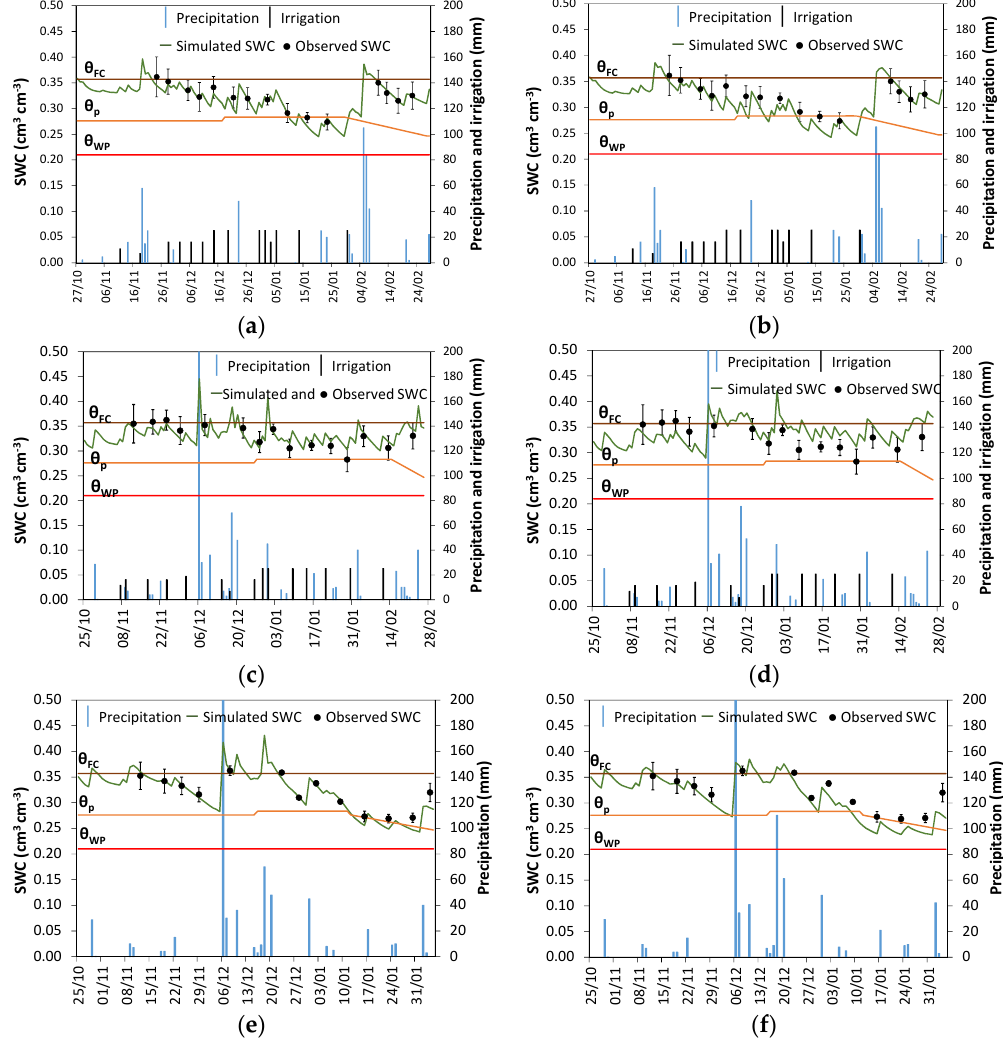
Figure 3. Simulated vs. observed seasonal variation of soil water content (SWC, cm 3 ∙ cm − 3 ) when using calibrated ( left ) and default parameters ( right ): a deficit irrigation case for 2011–2012 used for calibration ( a , b ); FI in 2012–2013 ( c , d ) and rainfed in 2012–2013 ( e , f ), both used for validation. ( θ FC and θ WP represent SWC at field capacity and wilting point, and θ p is the SWC threshold for no stress; error bars represent the standard deviation of the SWC measurements). Also depicted precipitation and irrigation.